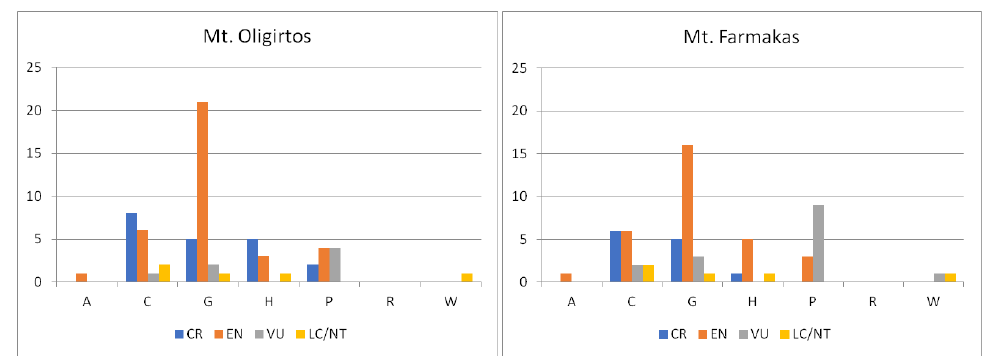
Figure 2. Classification of the Greek endemic taxa of Mts. Oligirtos and Farmakas in IUCN Red List categories, according to the main habitats each of the endemic plants prefers. LC/NT: Least Concerned/Near Threatened, VU: Vulnerable, EN: Endangered, CR: Critically Endangered. A: Freshwater habitats, C: Cliffs, rocks, walls, ravines, boulders, G: Temperate and submediterranean grasslands, H: High mountain vegetation, P: Xeric Mediterranean phrygana and grasslands, R: